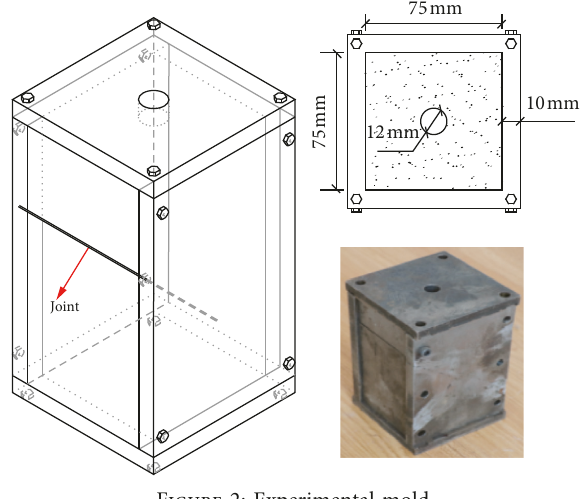
Figure 2: Experimental